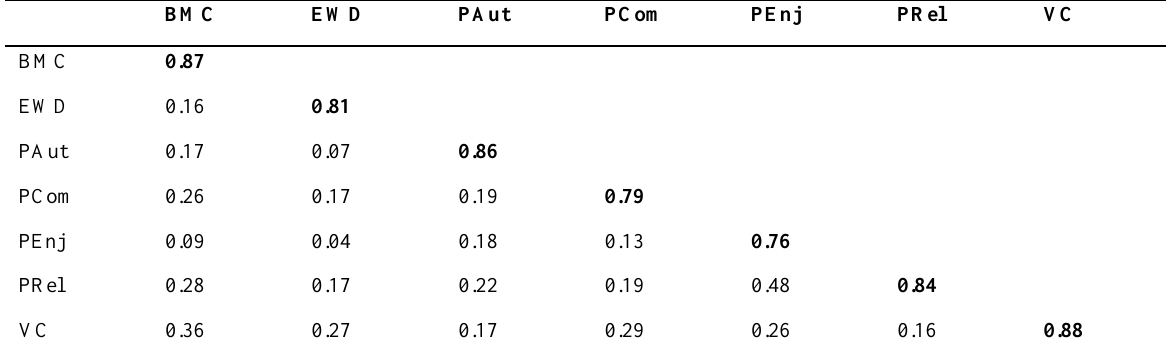
Table 2 : Discriminant Validity Analysis (Fornell-Larcker Criterion)